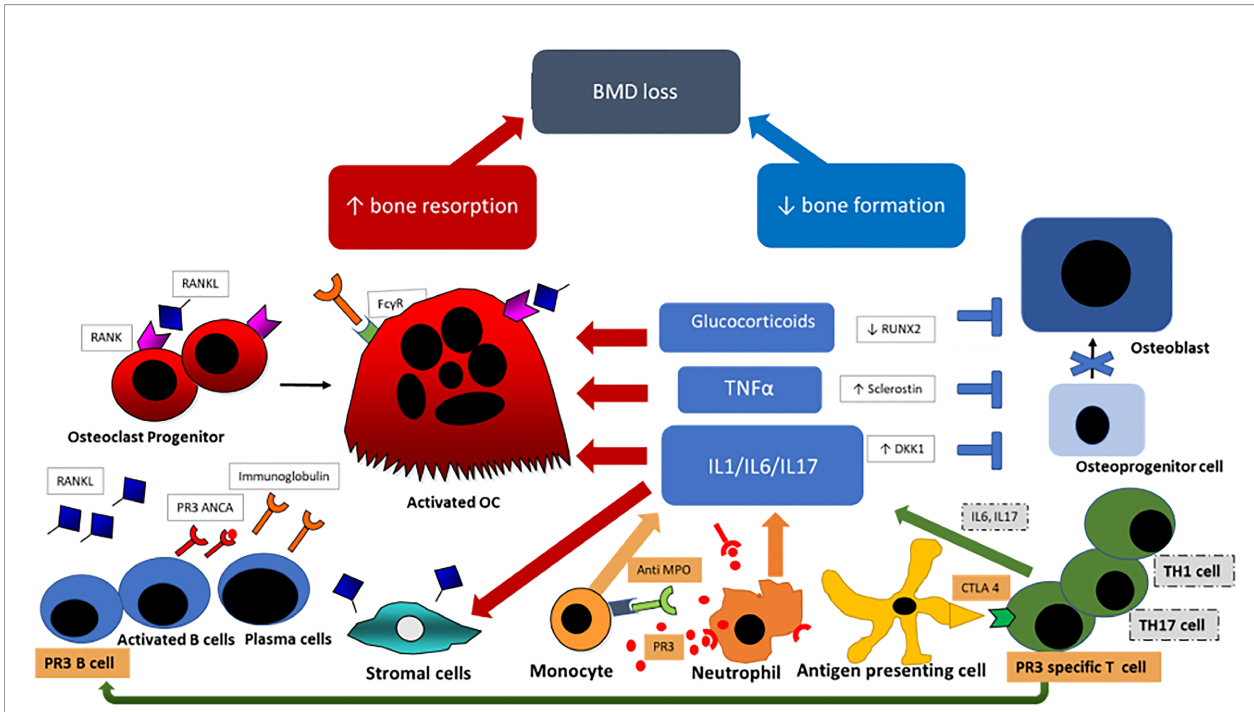
FIGURE 1 | Pathogenesis of bone loss in vasculitis; Anti-neutrophil cytoplasmic antibody (ANCA)-associated vasculitis speci fi c cells and antibodies are highlighted in orange. Primed neutrophils express PR3 [proteinase 3] or MPO [myeloperoxidase] which bind ANCAs and trigger further neutrophil activation and through CD4+ T- lymphocytes stimulation further ANCA production by B-lymphocytes. Key cells and cytokines in the pathogenesis of large vessel vasculitis {LVV} are highlighted in gray. Dendritic cells in the adventitia trigger the in fl ammatory cascade by activation of T-lymphocytes, predominantly T helper 1 (Th1) and Th17 cells, and express interferon and IL17. Primed neutrophils and Th cells promote proin fl ammatory cytokine production (Interleukin-6 (IL6), IL1 and Tumour Necrosis Factor (TNF)-alpha) which stimulates osteoclastogenesis through increased RANKL production by stromal cells and through direct osteoclast stimulation. In fl ammatory cytokines also inhibit the formation of osteoblasts by increased DKK1 and Sclerostin expression. Glucocorticoids suppress osteoblastogenesis by RUNX2 suppresion and stimulates osteoclast proliferation and longevity. BMD, bond mineral density; RANK4, receptor activator of nuclear factor kappa-B (ligand); PR3, proteinase 3; ANCA, anti-neutrophil cytoplasmic antibody; Fc g R, Fc gamma receptor; OC, osteoclast; TNF a , tumuor necrosis factor alpha; IL, interleukin; MPO, myeloperoxidase; RUNX2, runt-related transcription factor 2; DKK1, Dickkopf WNT Signaling Pathway Inhibitor 1; CTLA 4, cytotoxic T-lymphocytes antigen 4; TH1/TH17, T-helper type 1/type 17